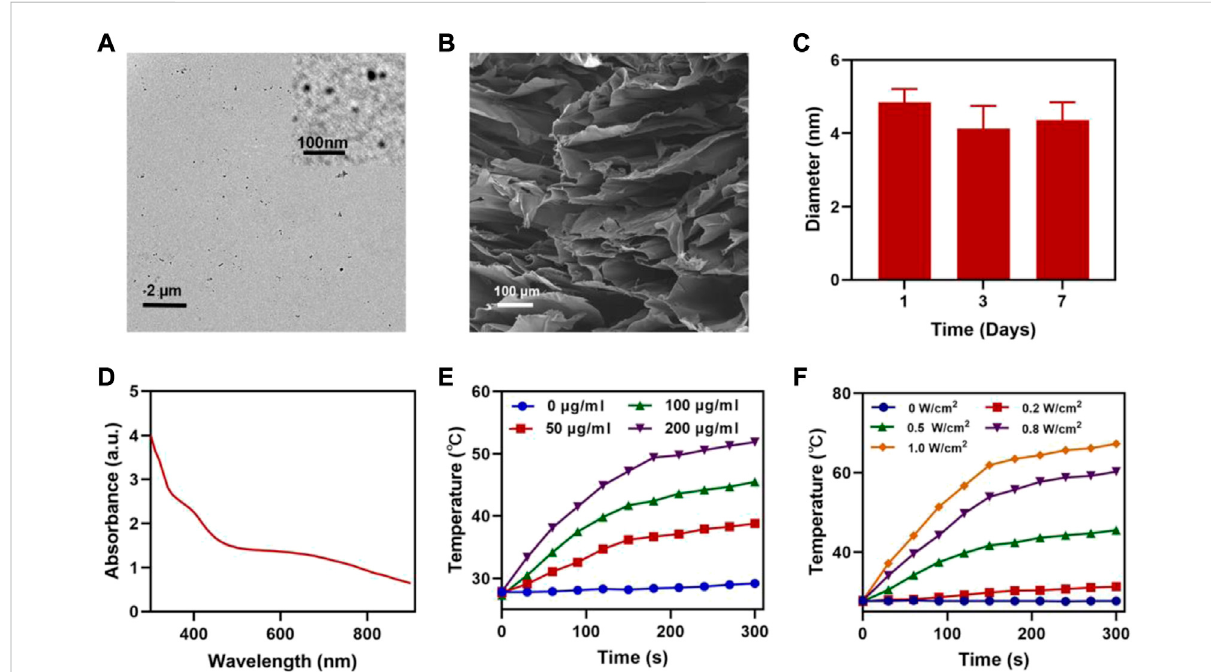
FIGURE 1 (A) TEM image of FeGA NPs (inset FeGA). (B) SEM image of FBH. (C) Hydrodynamic sizes of FeGA NPs. (D) UV-Vis absorption spectrum of FBH. (E) Temperature curves of FBH containing FeGA NPs with different concentrations under 808 nm laser at 0.5 W/cm 2 irradiation. (F) Temperature curves of FBH containing 100 μ g/ml FeGA NPs under different power